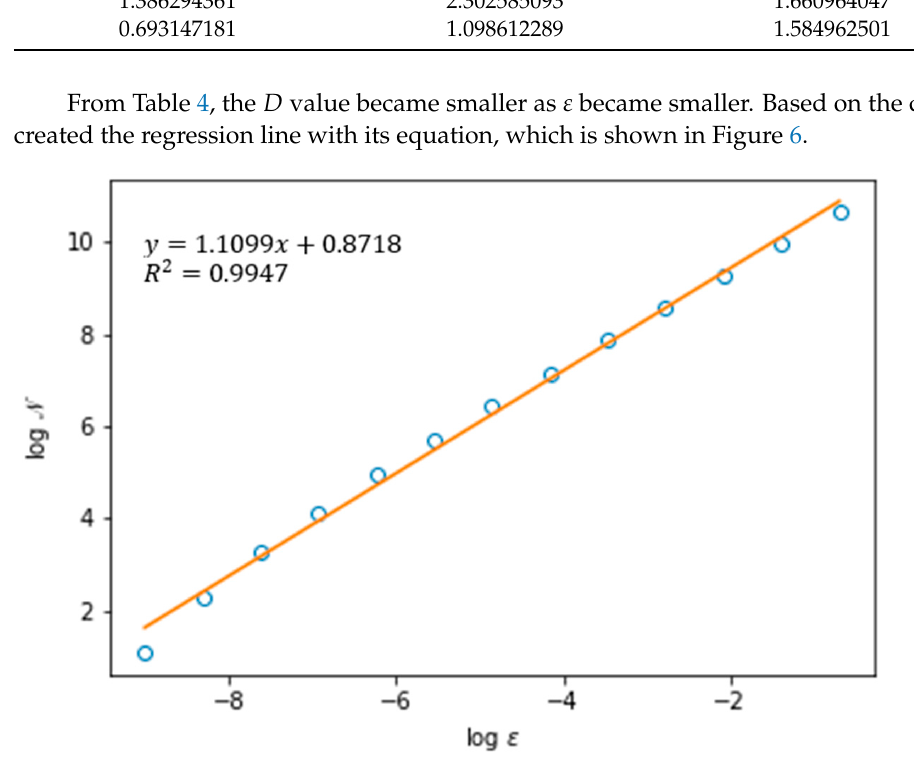
Figure 6. Linear regression of Table 4.